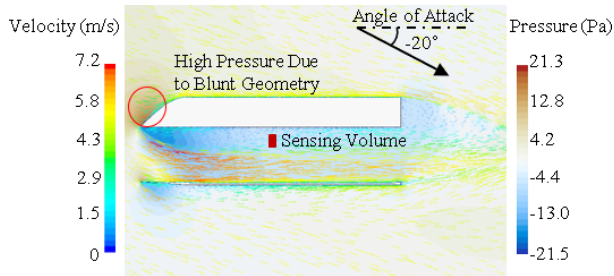
Figure 3. A vector plot of CFD simulation results for the original UCASS with an airflow angle of attack of 20 ◦ . The arrow represents angle of attack; the red circle is the high-pressure region, which di- rects particles around the sensing volume, labelled as a red square. The scale on the right is gauge pressure, corresponding to the colour of the background; the scale on the left is airflow velocity magni- tude, corresponding to the colour of the glyphs.